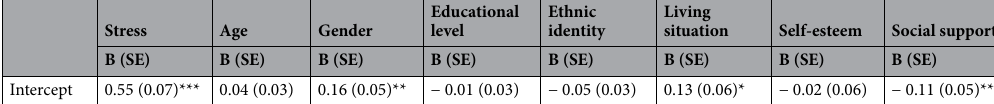
Stress Age Gender